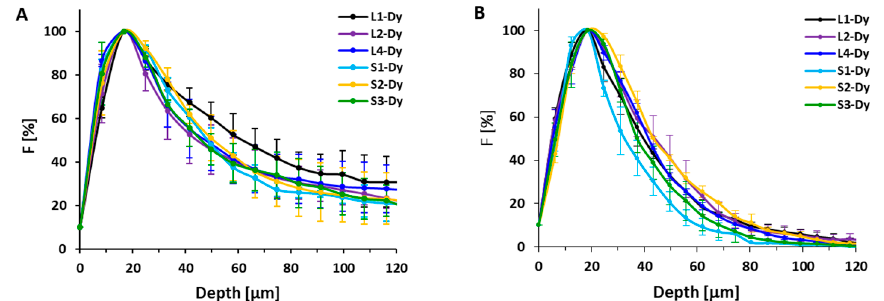
Figure 2. ( A ) Fluorescence profiles of fluorescently labeled HPMA-based polymer systems in C26 tumor spheroids after 24 h incubation, ( B ) fluorescence profiles of fluorescently labeled HPMA-based polymer systems in U87-MG tumor spheroids after 24 h. The fluorescence intensity dependence on the distance from the surface of the tumor spheroid was analyzed from several spheroids ( > 3). The percentage of fluorescence distribution is normalized to the maximum mean fluorescence intensity of the dye near the surface (100%) and outside the spheroid (0%).